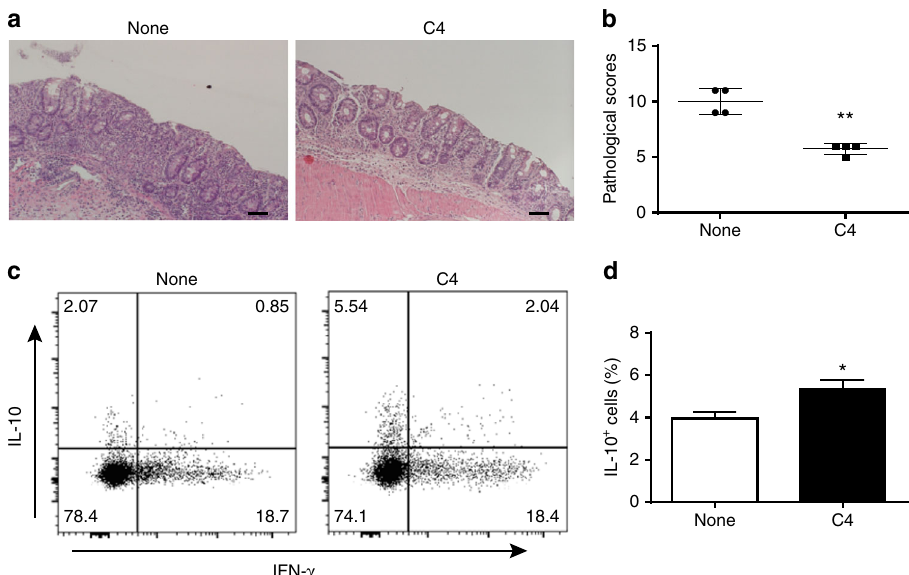
Fig. 9 Oral feeding butyrate protects colitis development induced by DSS. B6 mice were administered 1.7% DSS in drinking water for 7 days, followed by 3 days of water. One group ( n = 4 – 5) of mice were fed with butyrate (C4, 200 mM) in drinking water from day 0 when DSS was given. a Representative images of histopathology in cecum. Scale bar, 100 μ m. b Histopathological scoring. ** p < 0.01 Mann – Whitney U -test. c LP CD4 + T-cell IL-10 and IFN γ production was determined by fl ow cytometry. d Bar charts of the percentage of IL-10-expressing CD4 + T-cells. n = 4 – 5 per group per experiment. Data are one representative of 2 independent experiments; * p < 0.05 Student ’ s t